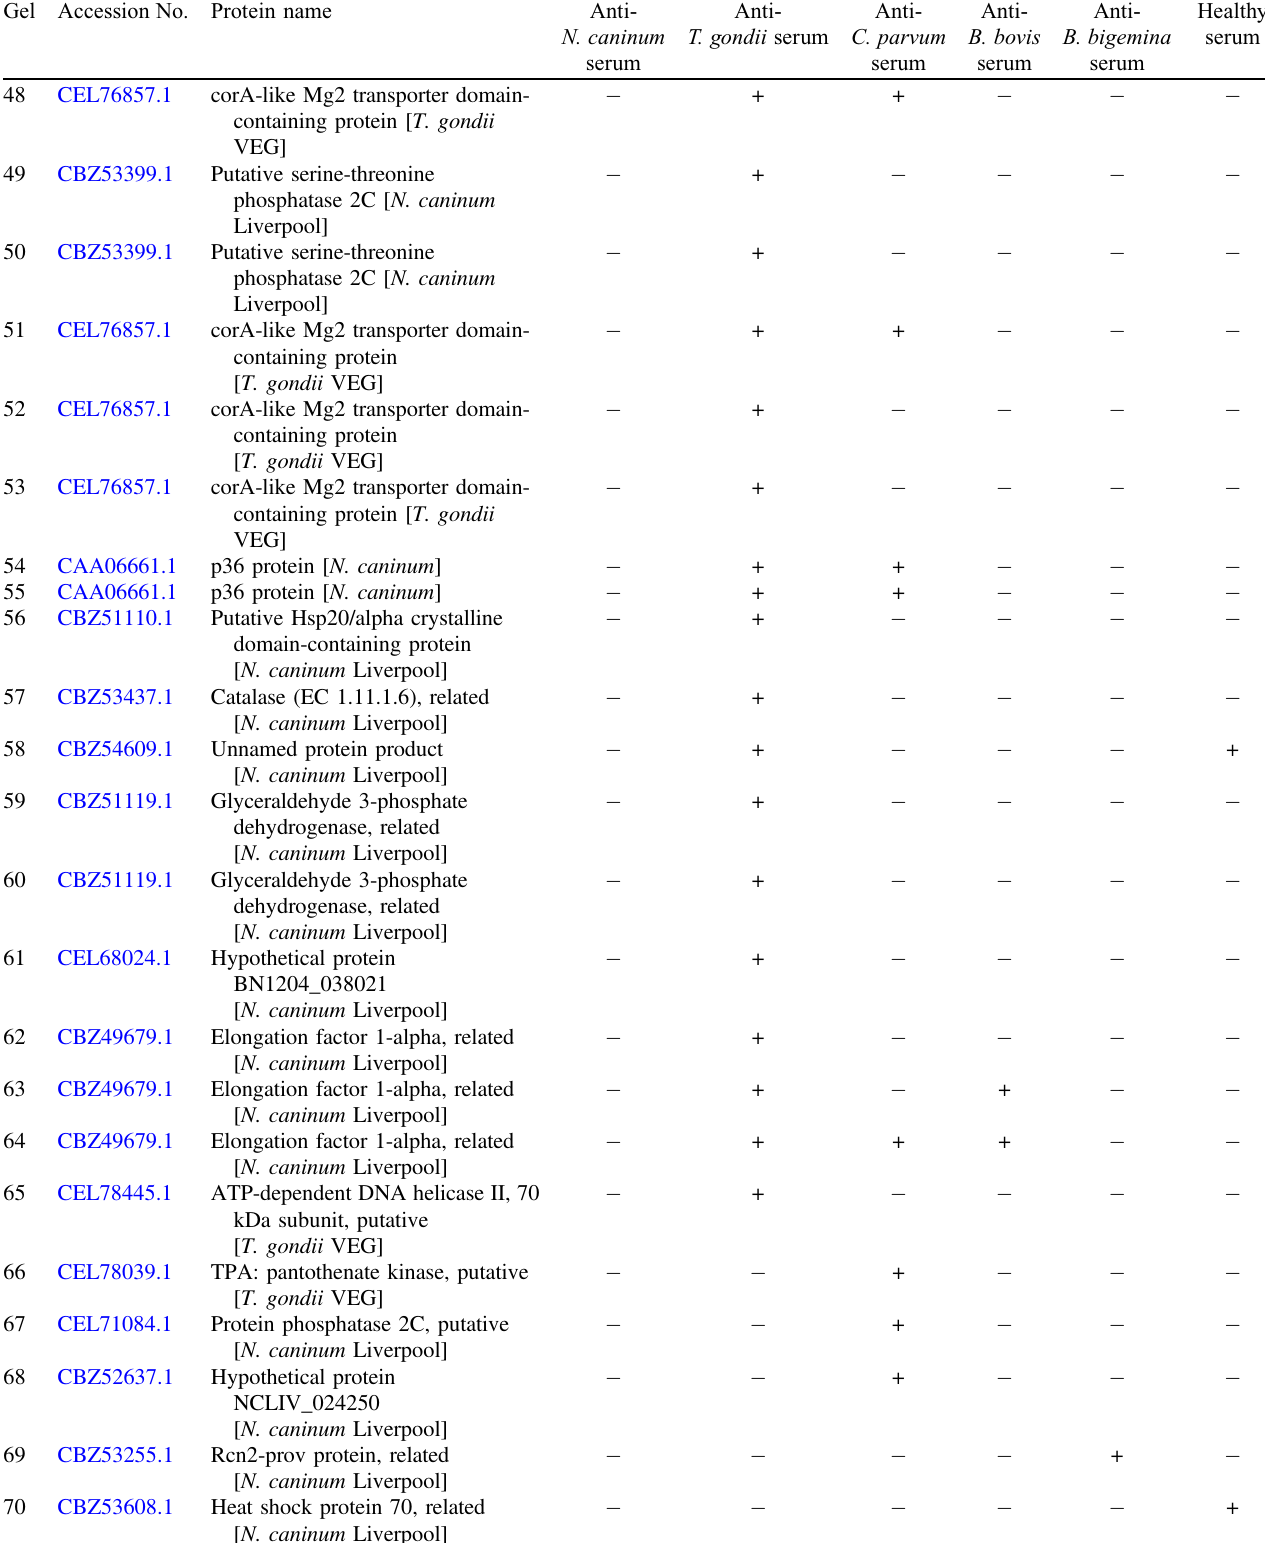
+ , Protein identi fi cation as antigenic proteins; – , Protein identi fi cation as non-antigenic proteins; + a , Protein identi fi cation as antigenic proteins speci fi c with anti- N. caninum